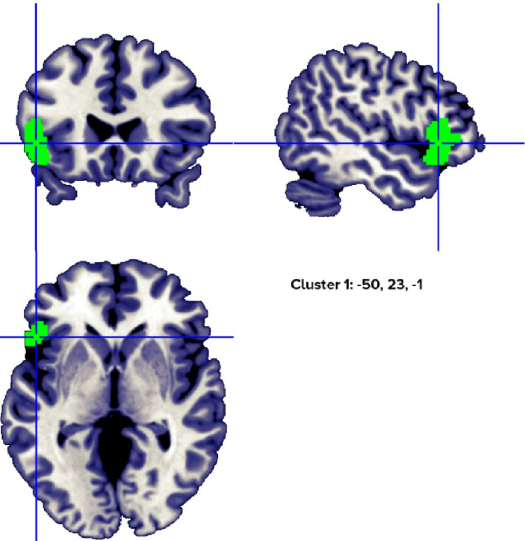
Figure 7. Clusters activated by the abstract > concrete nouns contrast. The crosses are centered in the areas correspond to stereotactic coordinates reported in Table 7. The images are presented in neurological